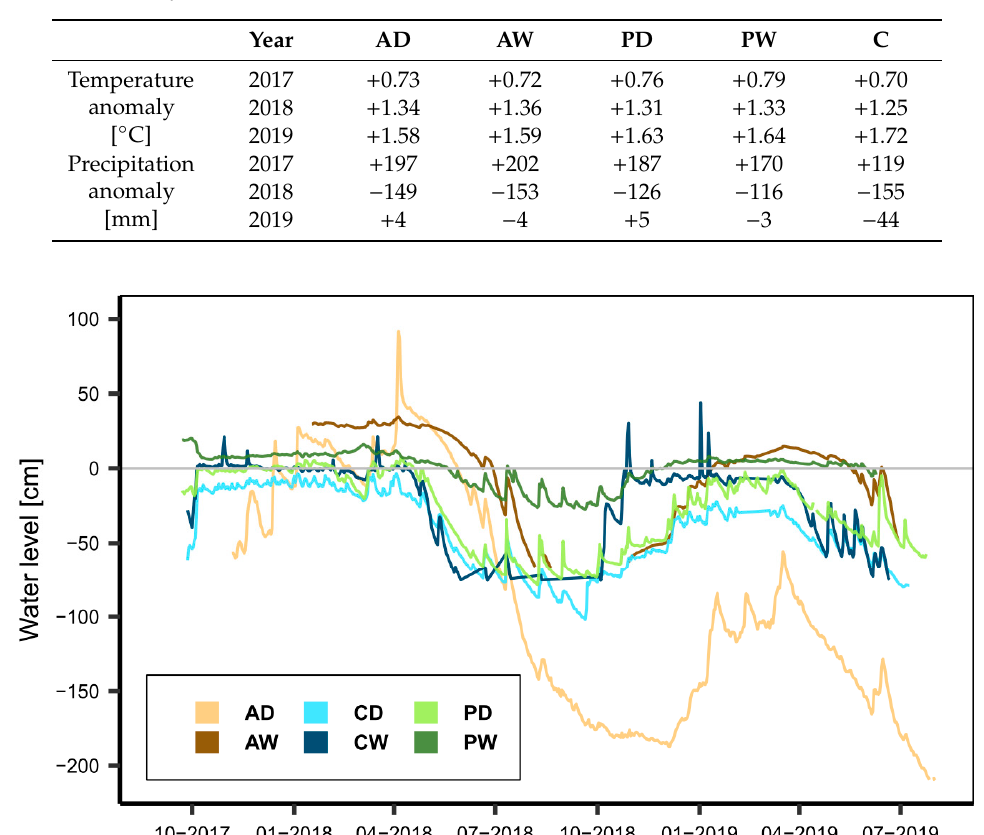
Table 3. Climatic variation, i.e., di ff erences between annual average temperatures (temperature anomaly) and annual sum of precipitation (precipitation anomaly) during the observation years and the average values during the climate reference period (1981–2010). All data were derived from the grid product of the German Water Service (freely available). The values were calculated based on monthly sums for precipitation and monthly averages for temperatures, which were extracted from the grid cells within which the study sites are located. The coastal sites are located in the same grid cell, hence there is only one column.